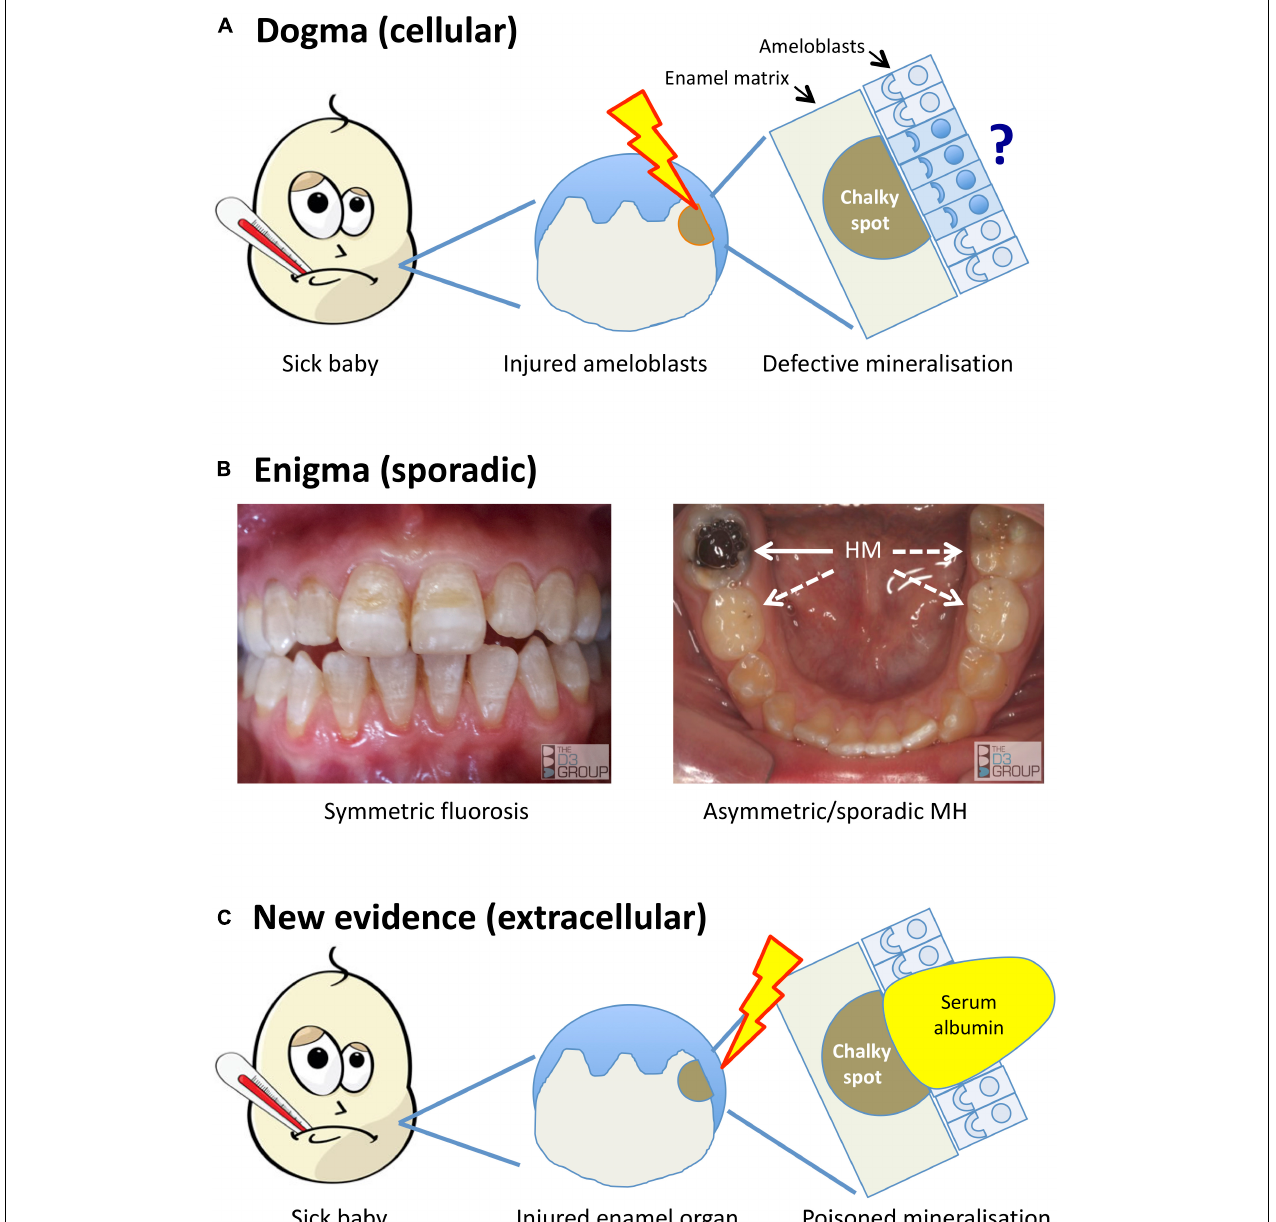
FIGURE 1 | Alternative models for the pathogenesis of MH. Translational portrayal of key pathological concepts presented in the text. (A) Current understanding holds that childhood illnesses ( sick baby ) lead to a systemic disturbance that causes cytotoxic injury ( lightening bolt ) to enamel-forming cells ( ameloblasts ). The pathomechanistic relationship between injured ameloblasts ( sad face ) and defective mineralisation of enamel matrix ( chalky spot ) remains unexplained, as does localisation of the injury to some ameloblasts and not others ( question mark) . (B) A persisting enigma is that MH presents sporadically, unlike dental fluorosis and other enamel defects (symmetric, chronological) that link logically to systemic disruptions. The left panel shows a moderately severe case of fluorosis, with co-linear enamel opacities extending symmetrically across multiple teeth. In contrast, the illustrated MH case ( right panel ) involves a single, severely hypomineralised (HM) 6-year molar ( solid arrow ) – note that despite advanced decay of the affected tooth, its partner on the other side and both 2-year molars appear grossly normal ( broken arrows ). Because MH can involve any number from 1- to all-4 of each molar type (cf. sporadic phenotype), its pathomechanism must contain a localising element. (C) New evidence described in the text implicates an extracellular pathomechanism that disrupts enamel-hardening directly ( poisoned mineralisation ) following exposure to serum albumin. Rather than invoking injured ameloblasts primarily, here the injury is envisioned to occur peripherally within the enamel organ ( lightening bolt), leading to localised exposure to albumin-enriched extracellular fluid (e.g., following vascular leak or haemorrhage). As such, this proposed extracellular pathomechanism has an intrinsic localising element that may account for the clinical characteristics of chalky opacities. Images courtesy of The D3 Group